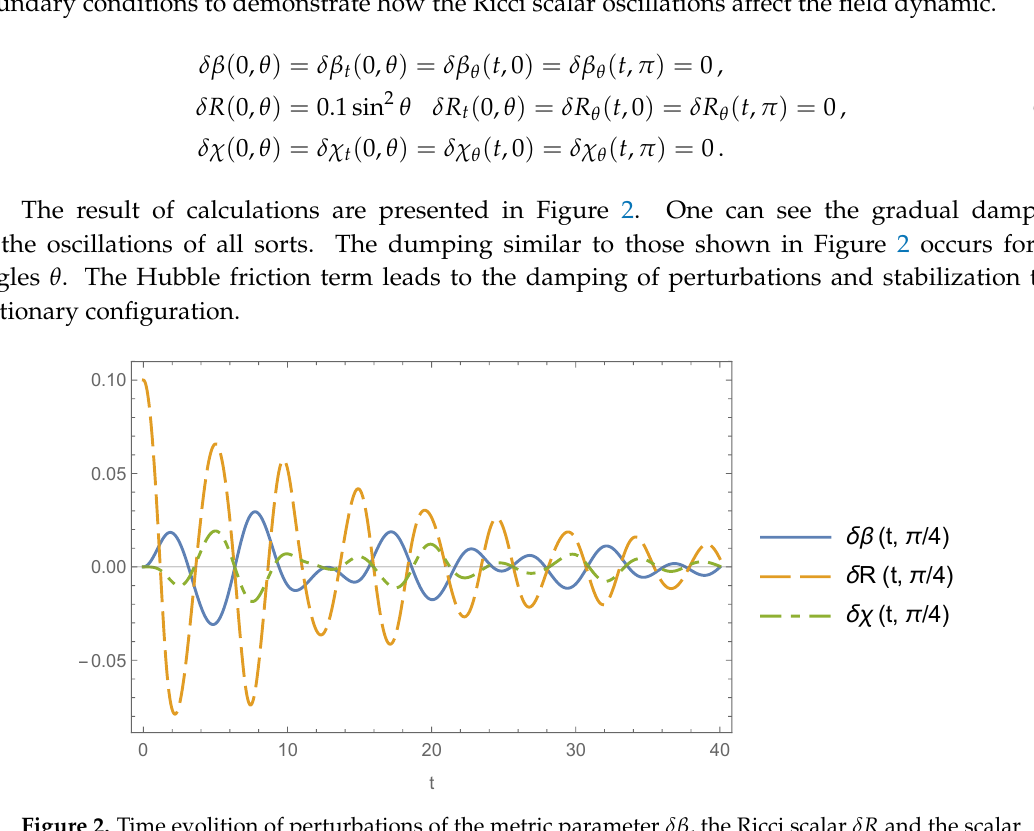
Figure 2. Time evolition of perturbations of the metric parameter δβ , the Ricci scalar δ R and the scalar field δχ for angle θ = π /4. The perturbation are the n = 2 standing wave mode along φ